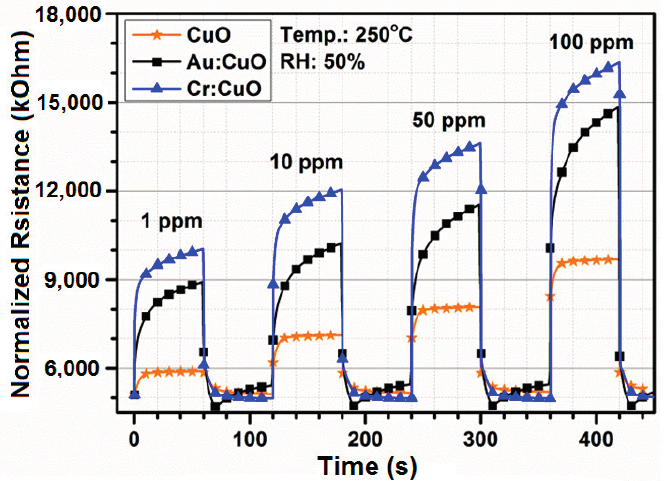
Figure 13. Propane curves of the CuO-based, Cr:CuO-based and Au:CuO-based sensor at 250 °C at multiple concentrations.